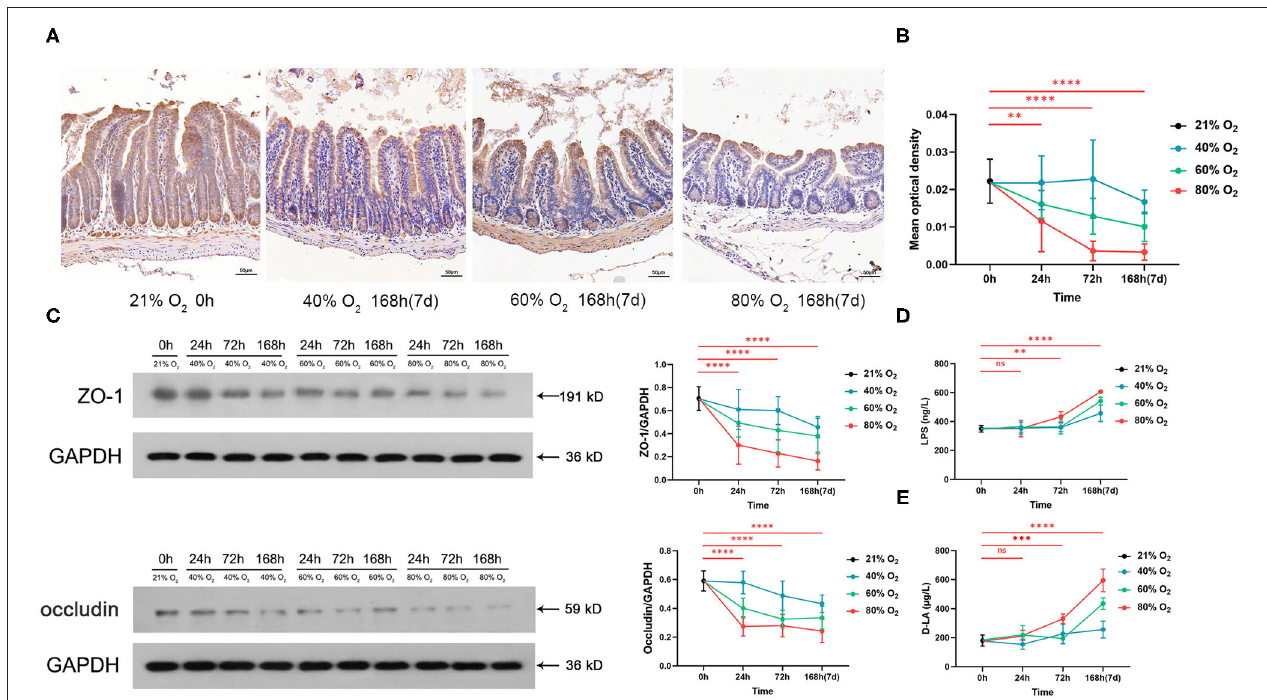
FIGURE 3 | Hyperoxia induces time- and dose-dependent gut barrier dysfunction and endotoxemia ( n = 6). (A) Representative intestinal immunohistochemical staining of ZO-1 sections from the control group and the oxygen groups (FiO 2 of 40, 60, and 80%) exposed for 168h (7 days). (B) The graph of the mean optical density of ZO-1 in the control and the oxygen groups. (C) Western blot and the graphs of ZO-1 and occludin levels in the control and the oxygen groups. (D) The graph of serum lipopolysaccharide (LPS) in the control and the oxygen groups. (E) The graph of serum D-LA in the control and the oxygen groups. LPS,